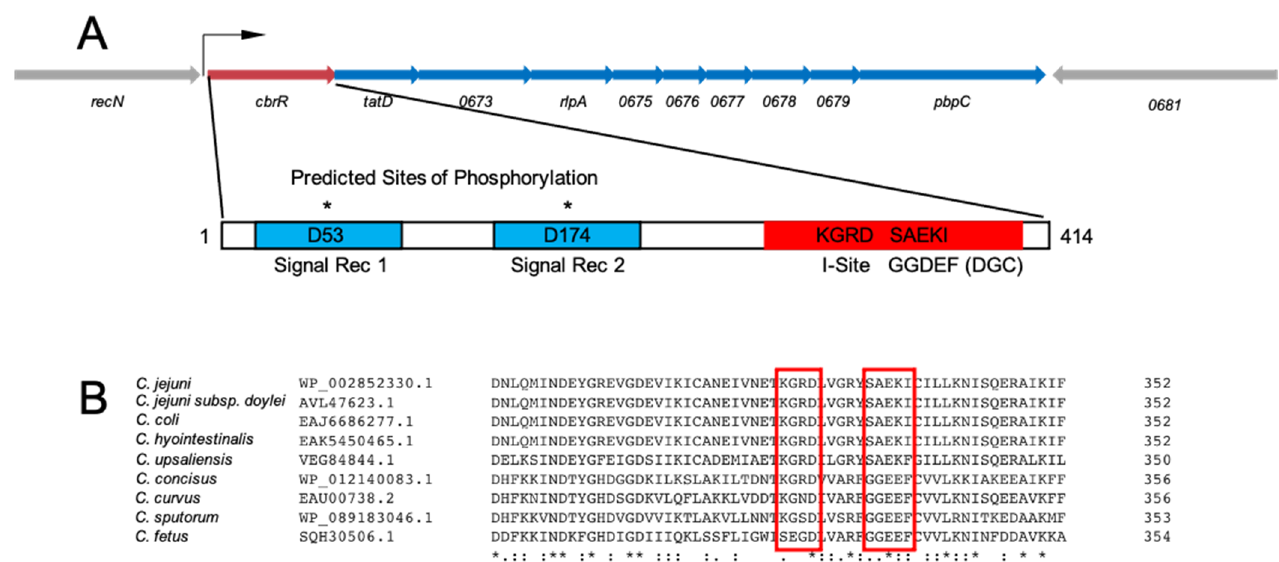
Figure 1. Gene and protein schematics for CbrR and the cbrR operon in C. jejuni 81–176. ( A ) The cbrR gene is the first of a predicted ten gene operon. For clarity, locus tags have been abbreviated to the last four digits. The bent arrow indicates the predicted transcription start site [68]. CbrR is 414 amino acid residues in length and is comprised of two N-terminal signal receiver domains (blue) with predicted sites of phosphorylation D53 and D174, and the GGDEF domain (red), which includes an autoinhibitory site (I-site). The GGDEF domain is indicative of diguanylate cyclase (DGC) activity. ( B ) A multiple sequence alignment shows that, though non-canonical, the amino acids comprising the I-site and active site are highly conserved within several clinically relevant Campylobacter species. Amino acid conservation is indicated by either an * (asterisk; fully conserved residues); a : (colon; amino acids with strongly similar properties; or a . (period; amino acids with weakly similar